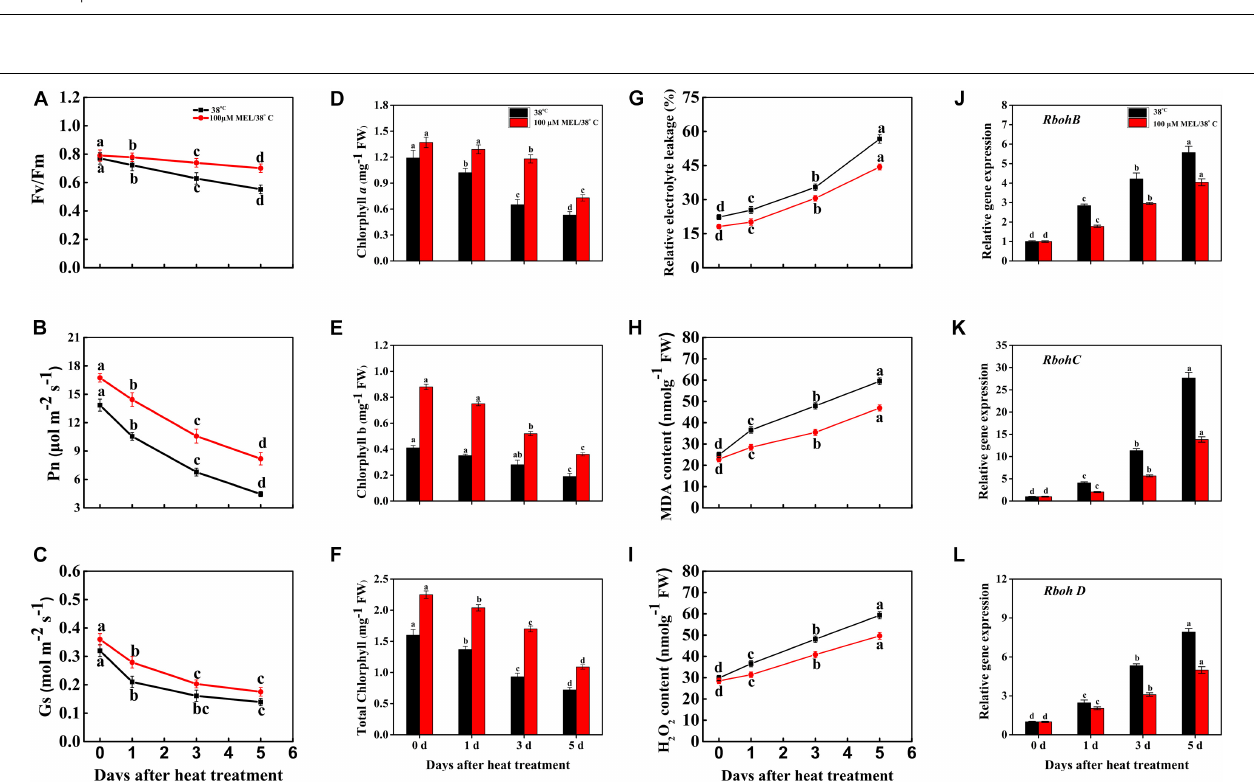
FIGURE 2 | Effects of exogenous melatonin treatment (100 µ M) on senescence associated physiological attributes in tomato under heat stress (38/28 ◦ C for 5 days). (A) Changes of Fv/Fm value, (B) net photosynthetic rate (P n ), (C) stomatal conductance (G s ), (D–F) changes of Chlorophyll content, (G) relative electrolyte leakage, (H) malondialdehyde (MDA), (I) hydrogen per oxide (H 2 O 2 ) content, (J–L) relative expression of Rbohs genes during heat stress with or without of melatonin treatment. Different letters denote the significant variations between the treatments and the average values were measured by Tukey’s Honestly Significant Difference (HSD) test at P < 0.05. Data represented as the mean ± standard error of triplicate biological replicates.